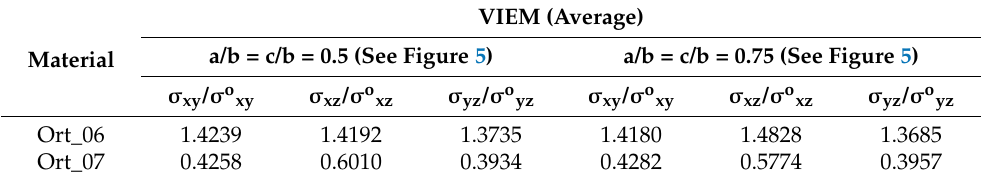
Table 21. Normalized shear stress components ( σ xy / σ o xy , σ xz / σ o xz and σ yz / σ o yz ) within the orthotropic prolate spheroidal inclusion due remote shear loading ( σ o xy , σ o xz and σ o yz ). VIEM (Average) a/b = c/b = 0.5 (See Figure 5) a/b = c/b = 0.75 (See Figure 5) Material σ xy / σ o xy σ xz / σ o xz σ yz / σ o yz σ xy / σ o xy σ xz / σ o